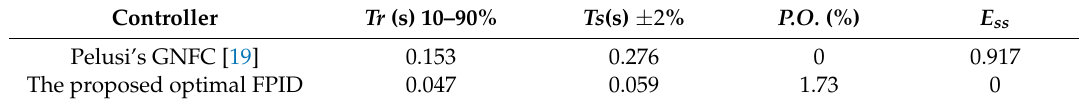
Table 2. Response performance of different